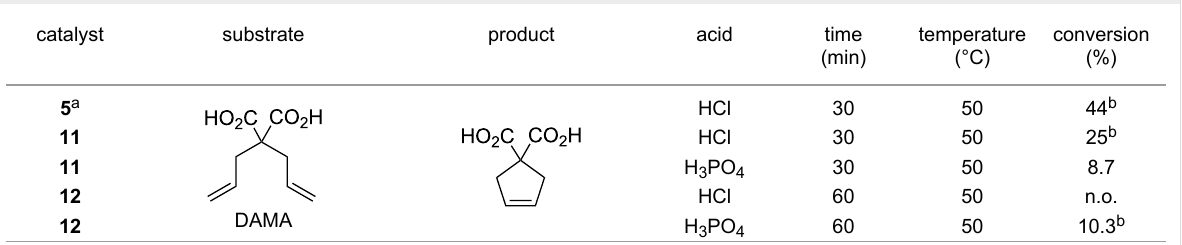
Table 3: RCM of diallylmalonic acid (DAMA) in 0.1 M aqueous acid ([Ru] = 2.0 mM, 4 mol % catalyst loading).